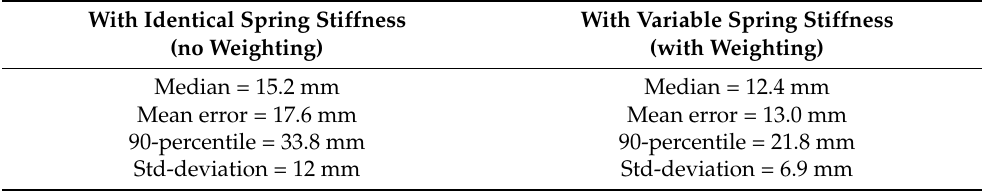
Figure 11. Cumulative distribution function, CDF, of spring-relaxation localization error. The red line corresponds to no weighting (uniform springs) being used. The blue line corresponds to weighting (variable stiffness springs) being used. Table 1. Localization accuracy of the proposed spring-relaxation algorithm. Table 1. Localization accuracy of the proposed spring-relaxation algorithm.